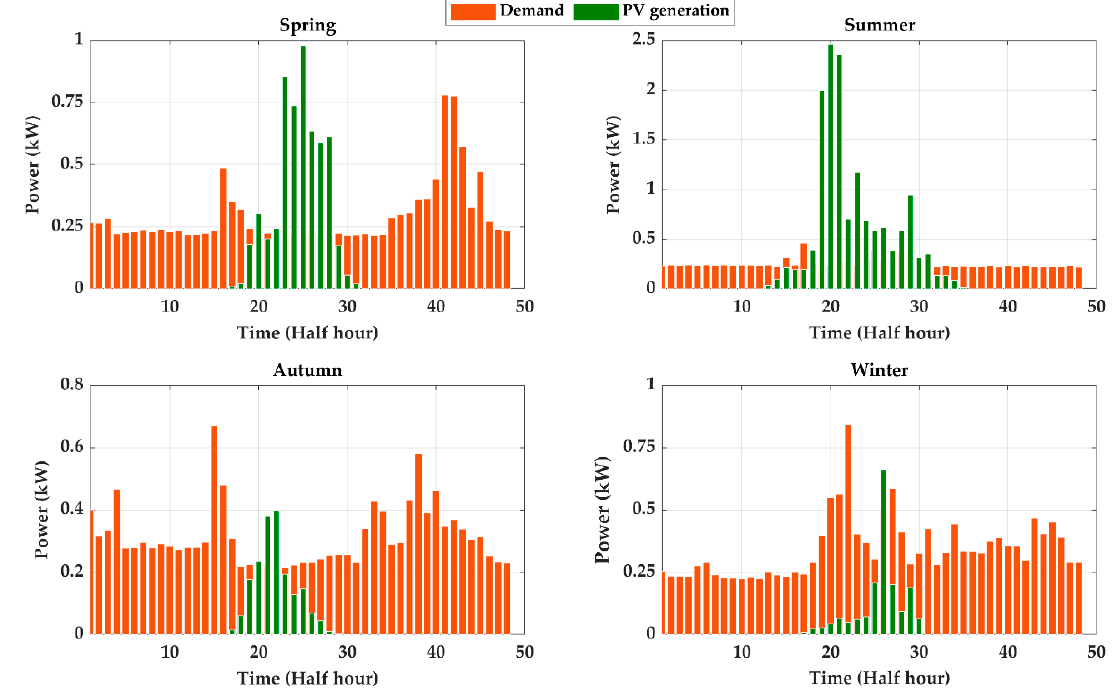
Figure 2. Solar PV generation and consumer load demand in the four seasons.